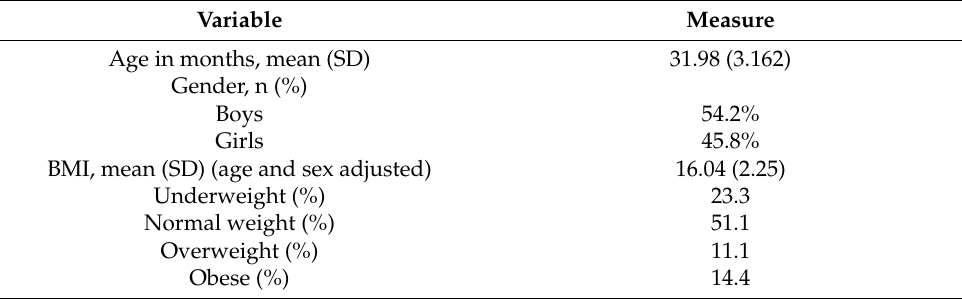
Table 1. Characteristics of toddlers ( n =